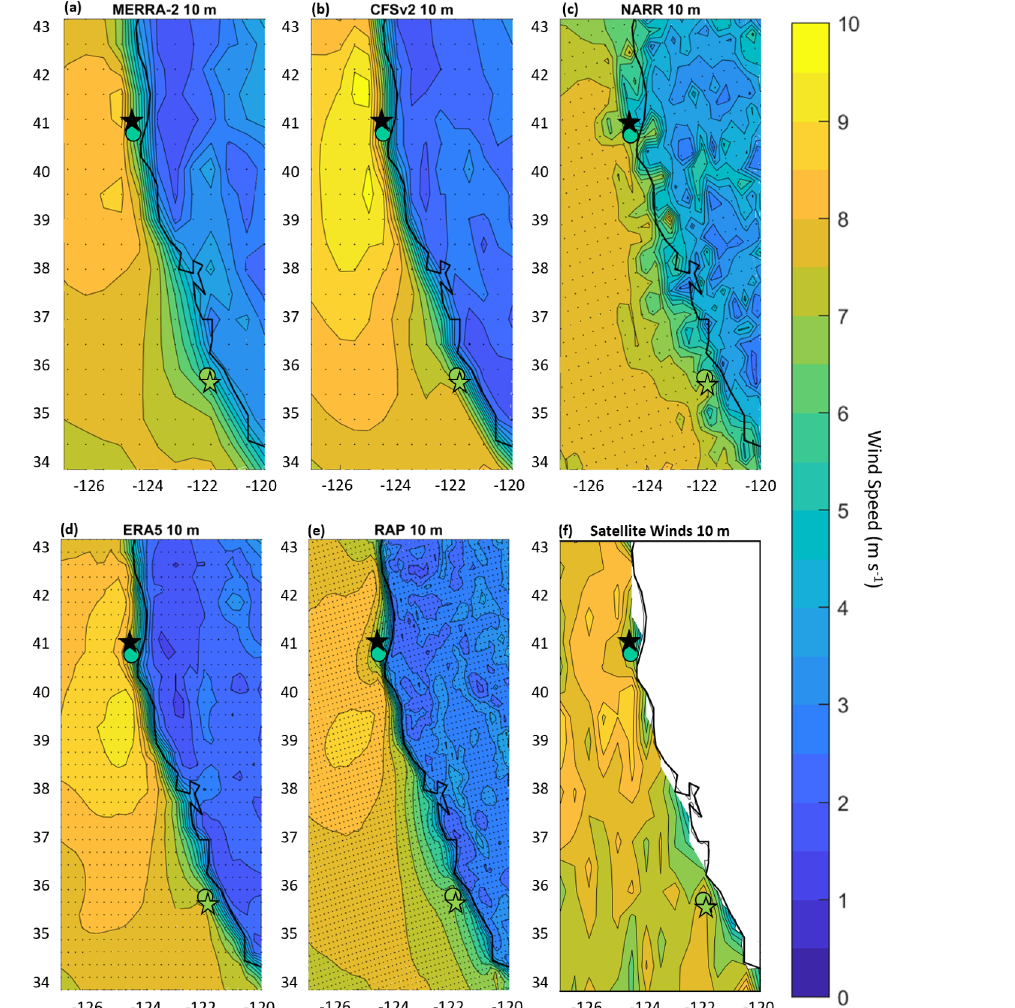
Figure 5. Average wind speed over the period 1 October 2020 through 30 September 2021 from (a) MERRA-2 at 10ma . s . l . , (b) CFSv2 at 10ma . s . l . , (c) NARR at 10ma . s . l . , (d) ERA5 at 10ma . s . l . , (e) RAP at 10ma . s . l . , and (f) the satellite winds at 10ma . s . l. Model grid points are indicated with dots. DOE buoy locations are indicated with stars, and Morro Bay is colored to reflect the average 4ma . s . l . wind speed over the period 1 October 2020 through 30 September 2021 (6.6ms − 1 ). NDBC buoy locations are indicated with circles and are colored to reflect the average 4ma . s . l . wind speed over the period 1 October 2020 through 30 September 2021 (5.8ms − 1 at the northern Humboldt location and 6.7ms − 1 at the central Morro Bay